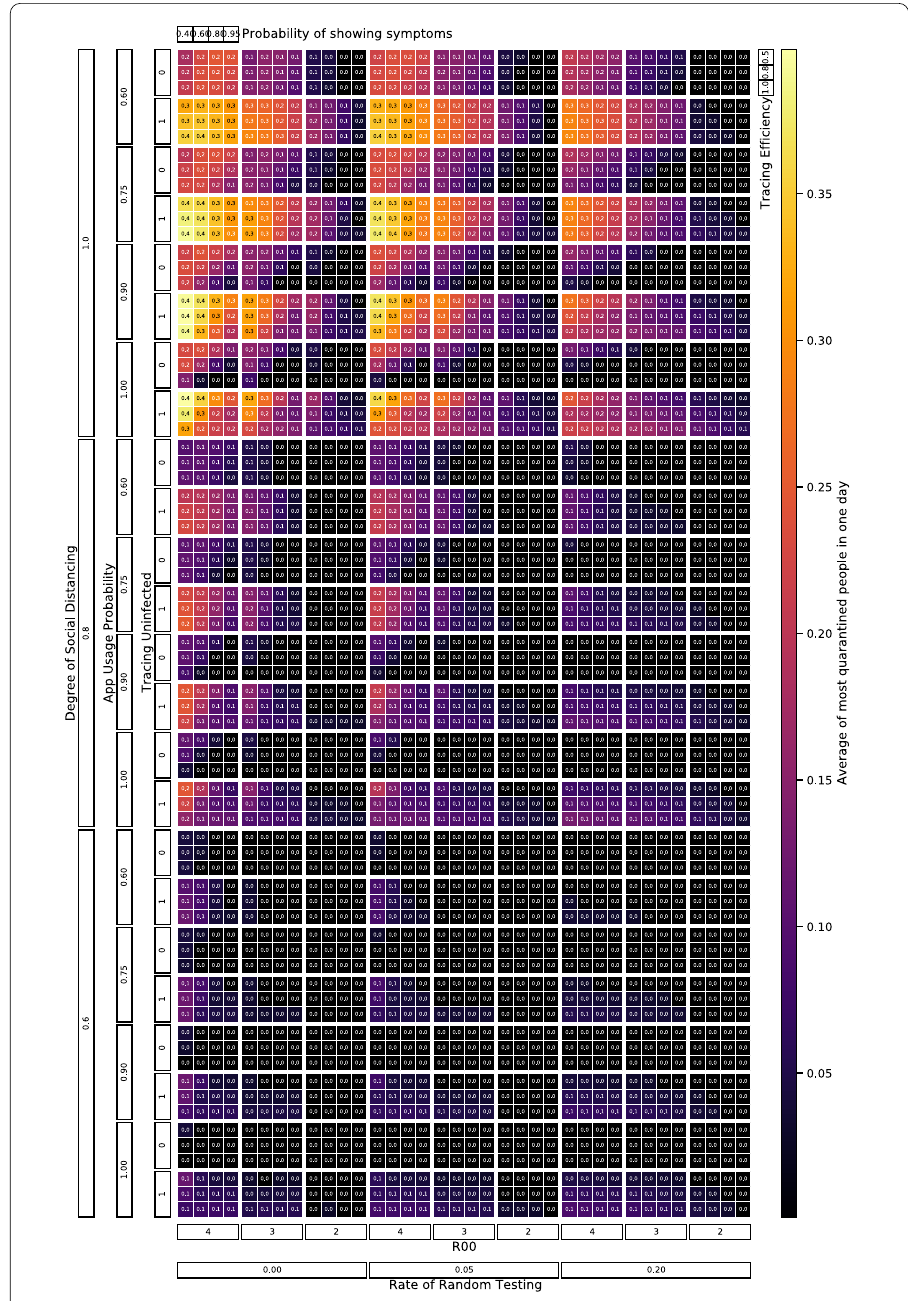
Figure 25 The fraction of the population that is quarantined on the day when most people are quarantined is shown for all combinations of parameters in the default parameter scan (black font color in Tab. 1)